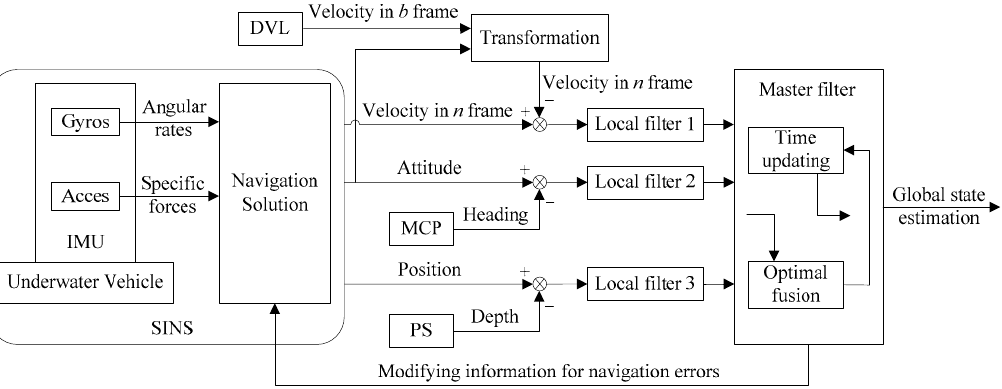
Figure 2. System structure based on the federated filter.